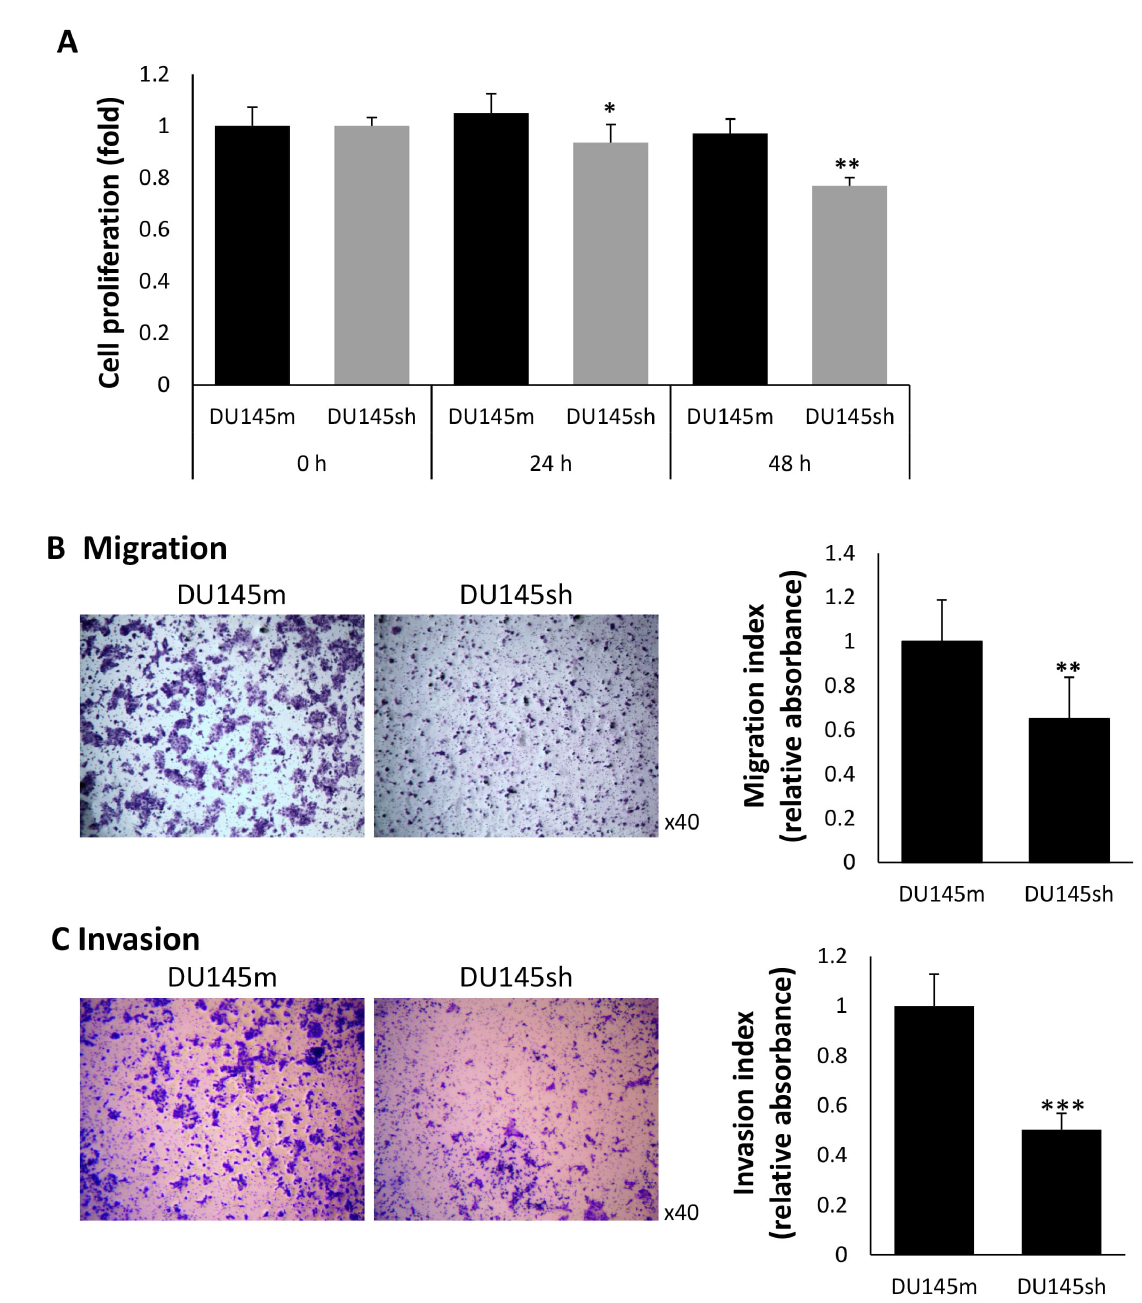
Fig. 2. Downregulation of TRPM7 inhibited cell proliferation, migration and invasion of prostate cancer cell. (A) Cell proliferation assay. DU145m and DU145sh cells were seeded in plate and cell viability was measured for indicated time period (0 h, 24 h, 48 h). (B) Migration assay. Cell migration was performed by transwell and cells were stained with crystal violet. (C) Invasion assay. All data are expressed as the mean ± standard deviation from three independent experiments. * p < 0.05; ** p < 0.01; *** p < 0.005 versus DU145m. Magnification: ×